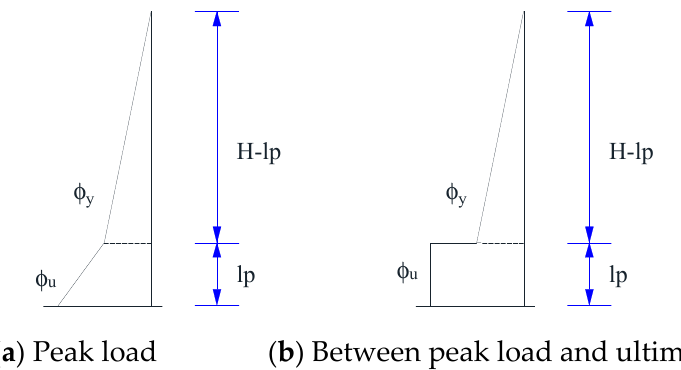
Figure 3. The distribution of the curvature of the shear wall under the peak load and ultimate load.